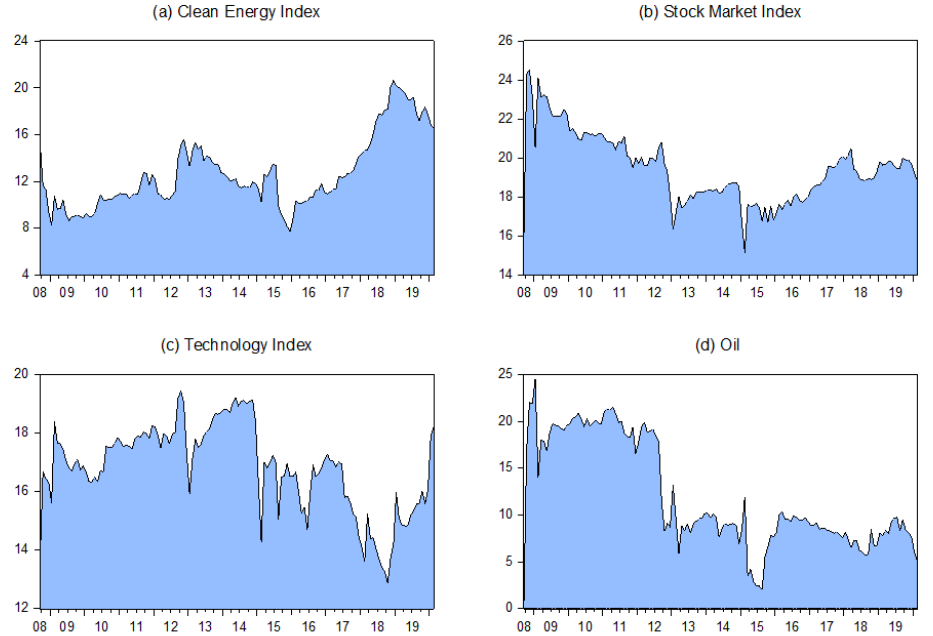
Figure 3. Directional spillovers TO among the clean energy (CE), S&P 500 (ST), technology (TE), and crude oil (WTI) series. Note: The x -axis indicates the time and the y -axis shows the percentage change in the directional spillover TO.